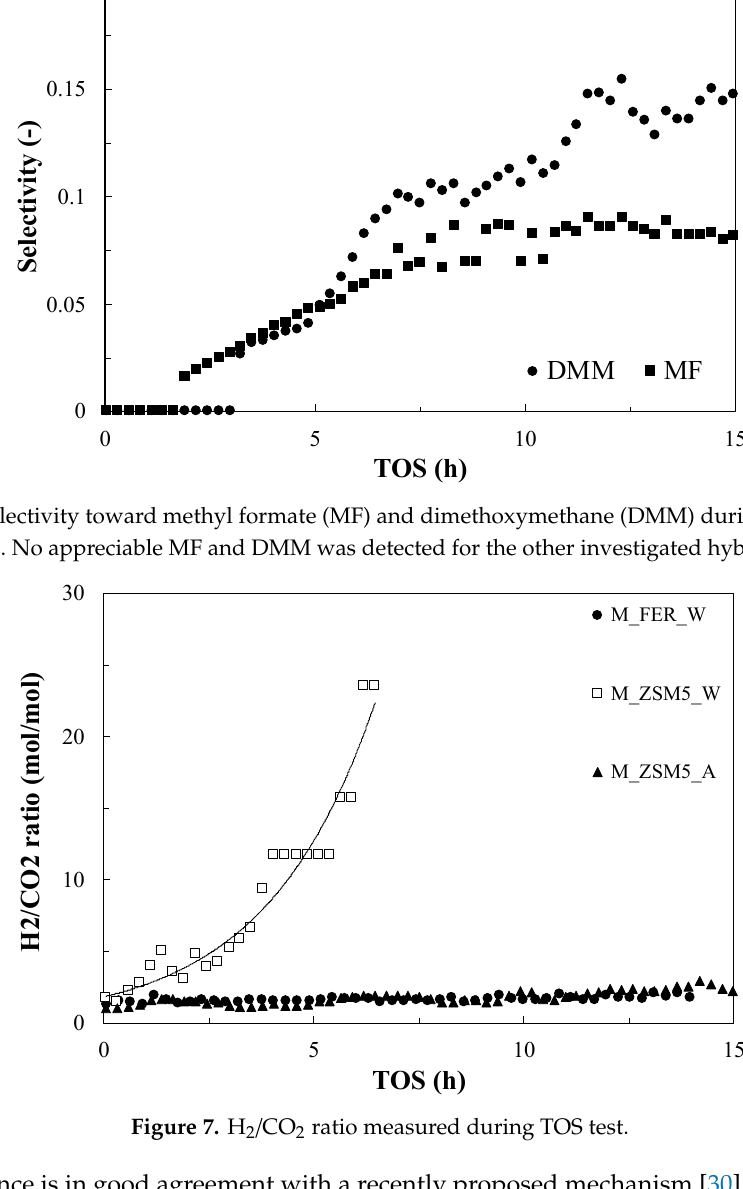
Figure 6. Selectivity toward methyl formate (MF) and dimethoxymethane (DMM) during TOS of the